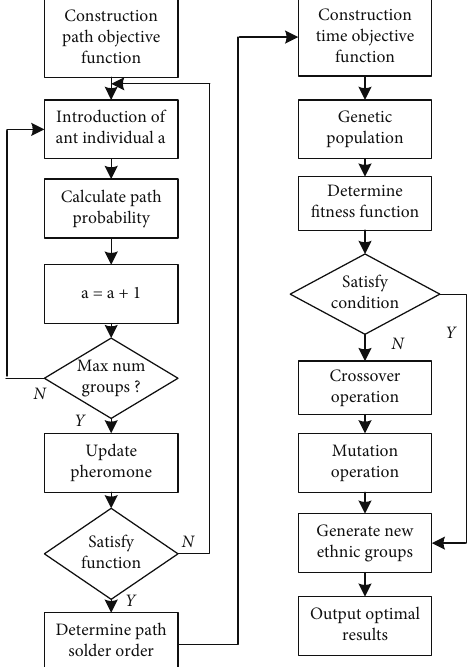
Figure 3: Overall process of welding robot path